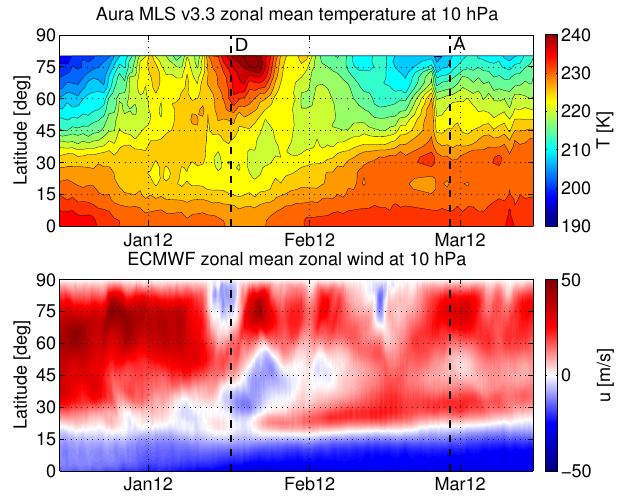
Figure 6. Northern hemispheric Aura MLS v3.3 zonal mean temperature in [ K ] (upper panel) and ECMWF zonal mean zonal wind in [ ms − 1 ] for the 10 hPa pressure level. The time period extends from mid-December 2011 to mid-March 2012. The left dashed black line indicates the date of TM case D and the right one TM case